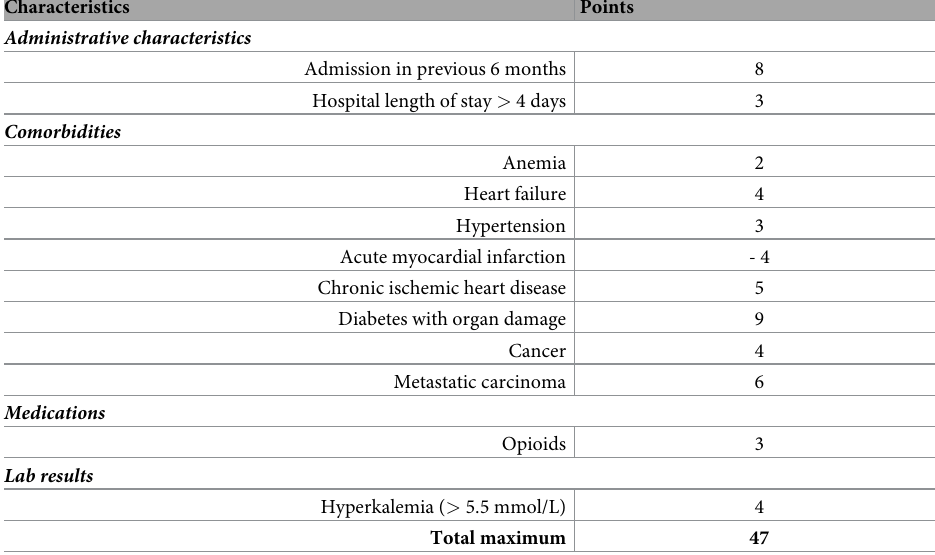
Table 3. Potentially avoidable readmission risk score (PAR-Risk